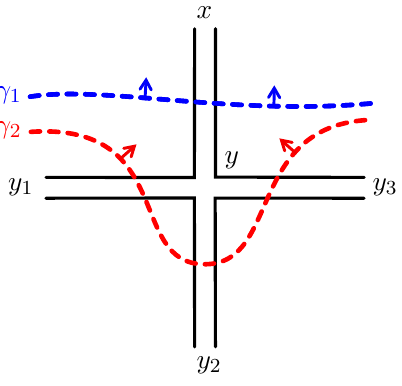
Figure 2 . Local cut deformation. Corresponding to the cuts (cid:13) 1 and (cid:13) 2 , the Feynman integral is modi(cid:12)ed as in (2.7) and (2.8), respectively. The two choices are equivalent. of the twist cut across an interaction vertex, such as the one from the blue to the green dashed lines in (cid:12)gure 1. Such a deformation can be recast as the action of the symmetry transformation on that integrated vertex and hence, modulo possible subtleties due to the regularisation scheme, does not change the result for the